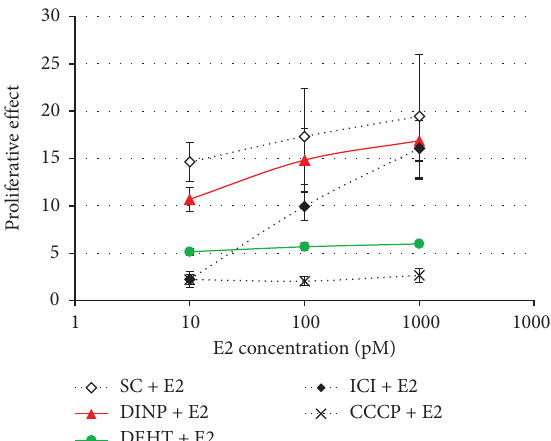
Figure 4: E-Screen antagonist competitive confirmation assay for DINP and DEHT. MCF-7 cells were exposed for 120h to DEHT 300 μ M or DINP 30 μ M in presence of increasing concentrations of E2. ICI 182,780 (ICI) and carbonyl cyanide 3-chlorophenylhydrazone (CCCP) were used as antiestrogenic and cytotoxic reference compounds. Results represent the mean ± SD of 3 replicates.